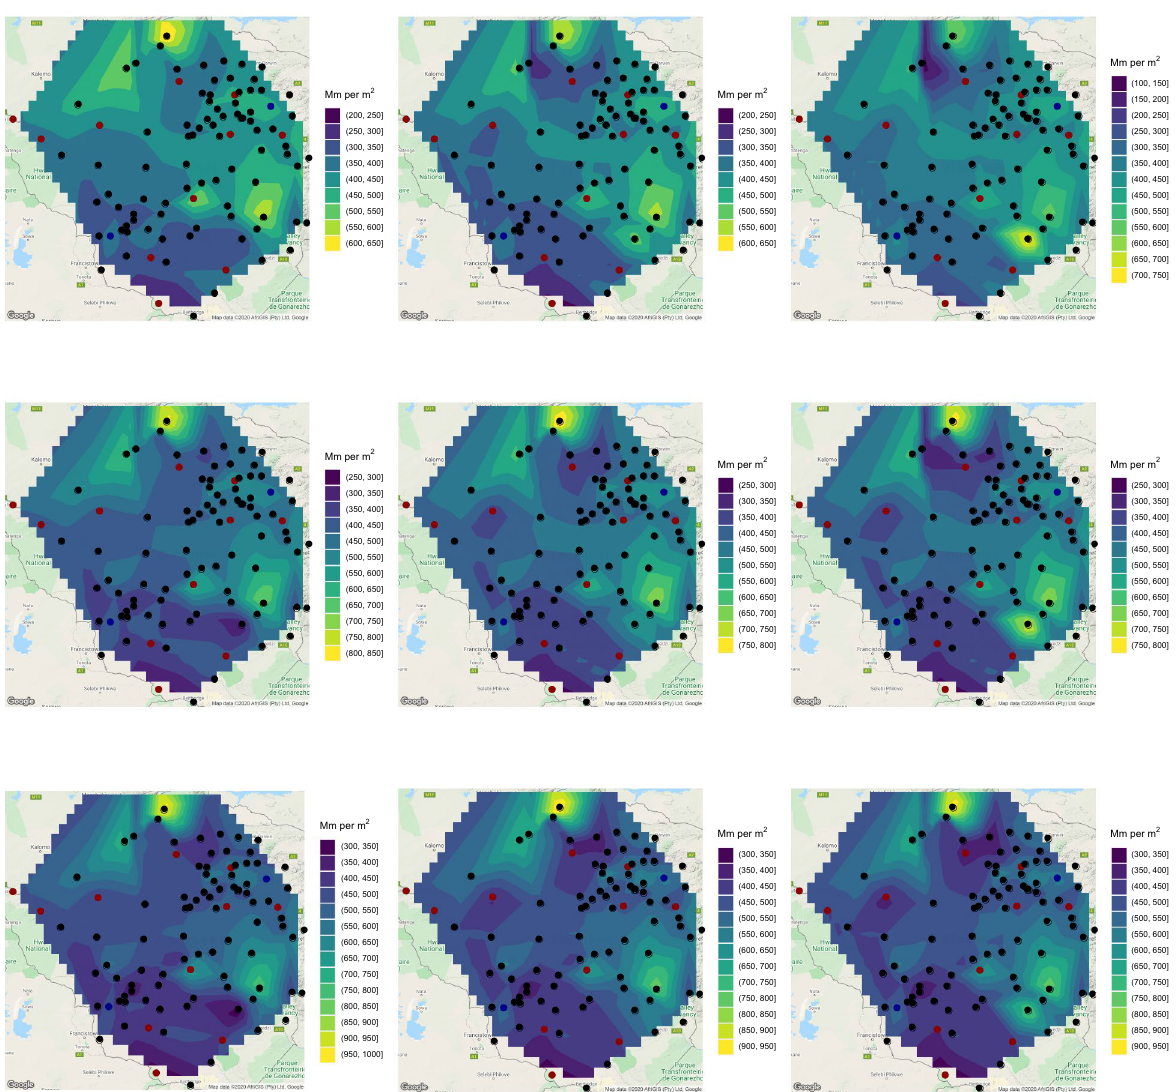
Figure 7. Estimates of 20-year return level (first raw, left), 20-year return level 10 years ahead (first raw, middle), 20-year return level 20 years ahead (first raw, right), 50-year return level (second raw, left), 50-year return level 10 years ahead (second raw, middle), 50-year return level 20 years ahead (second raw, right), 100- year return level (third raw, left), 100-year return level 10 years ahead (third raw, middle) and 100-year return level 20 years ahead (third raw, right). ggplot2 version 3.3.5, https:// cran.r- proje ct. org/ web/ packa ges/ ggplo t2/ index. html was used for